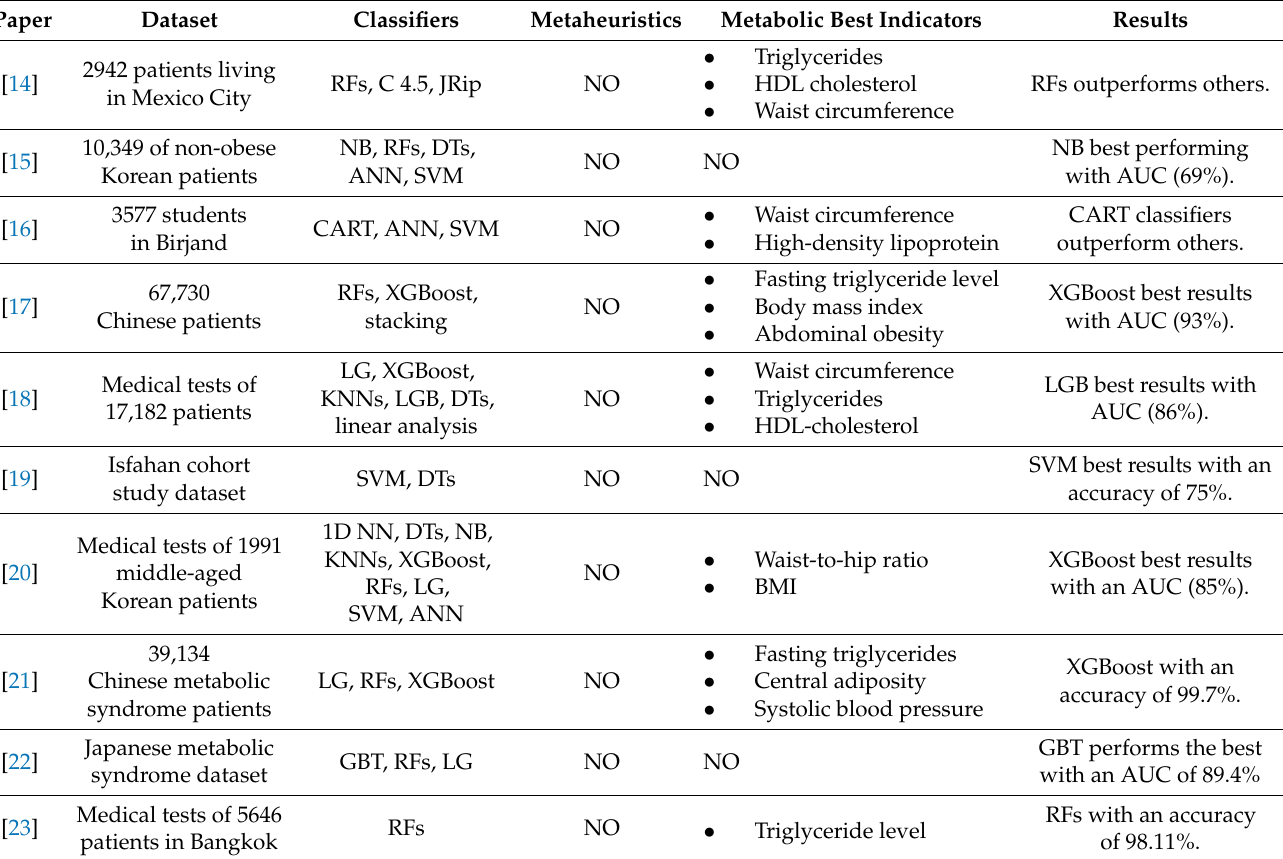
Table 1. Summary of the related